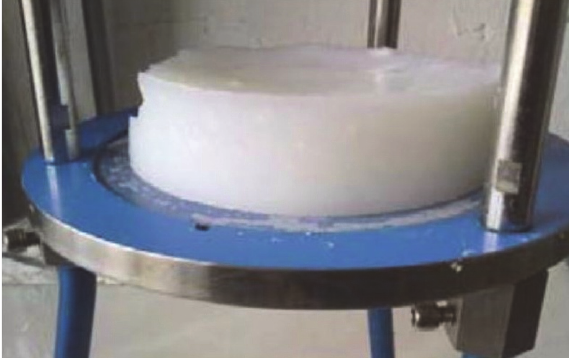
Figure 2: Macroscopic appearance of the boehmite gel obtained after